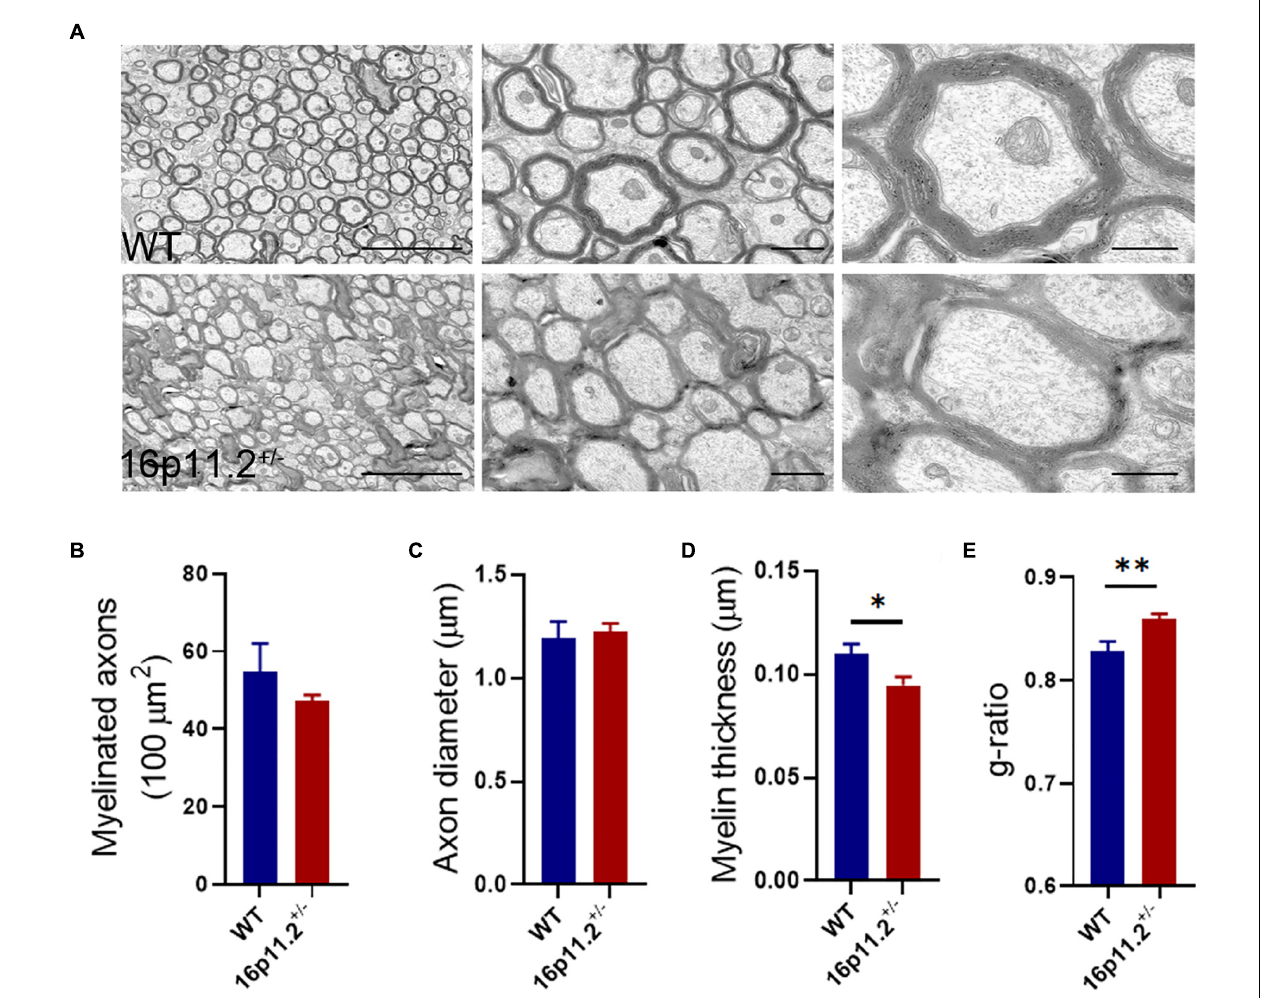
FIGURE 2 | Decreased myelin thickness in 16p11.2 ± striatum. (A) Representative TEM images of myelinated axons in the striatum of P60 16p11.2 ± mice (lower panels) and WT controls (upper panels). Scale bars, 5 µ m (left), 1 µ m (middle) and 0.5 µ m (right). (B–E) Comparison of myelinated axon number (B) , axon diameter (C) , myelin thickness (D) , and myelin g-ratio (E) in the striatum of 16p11.2 ± mice versus WT controls (3 mice per group). All myelinated axons were counted (B) but only clearly-defined myelinated axons were measured [ (C–E) , WT: n = 267, 16p11.2 ± : n = 131] in 15 microscope fields (5 field per mouse) under study for each group. Data were analyzed by unpaired t tests (mean ± SEM, * p < 0.05, ** p <